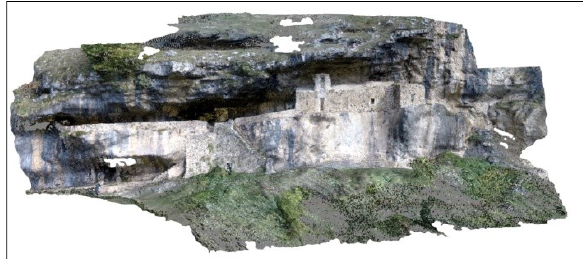
Figure 12. Image Based Point Cloud